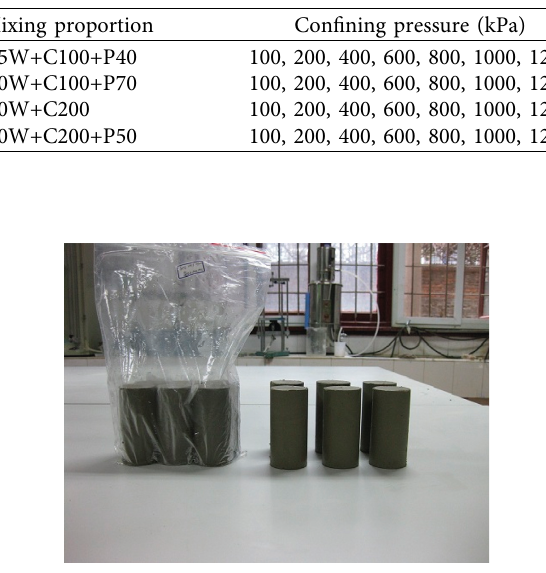
Figure 4: Specimens.